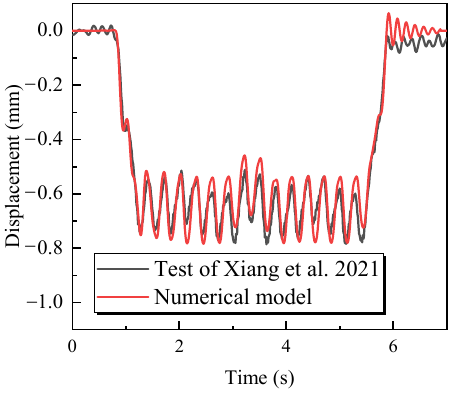
Figure 2. Validation of numerical model.